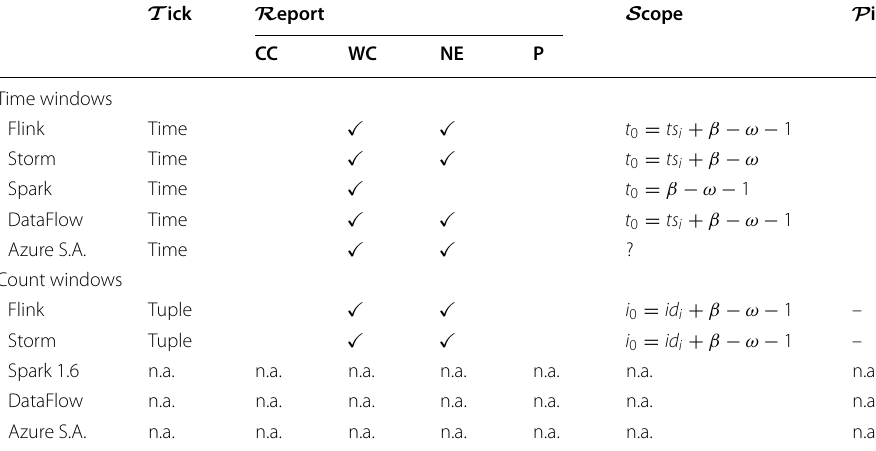
Table 1 Parameters identified for the SPEs under analysis T